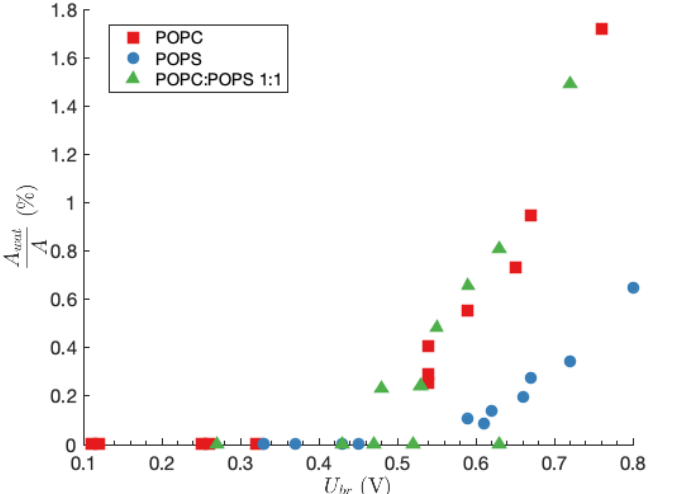
Figure 4. The fraction of the planar lipid bilayer area that is occupied by water pores as a function of U br